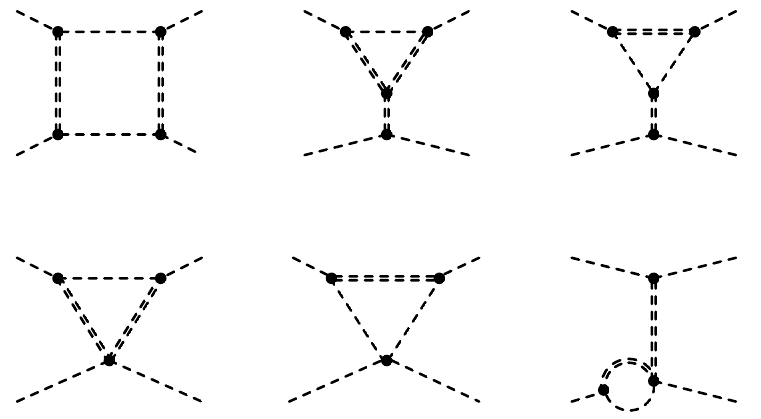
Figure 4 . Examples of heavy-light scalar contributions to the one-loop matching correction C (1) Diagrams with loops that contain only H (cid:12)elds are not shown, since they evaluate to zero in DR if the H (cid:12)elds are taken to be massless before Taylor expanding the corresponding loop integrals. The line styles and their meanings resemble those of (cid:12)gure